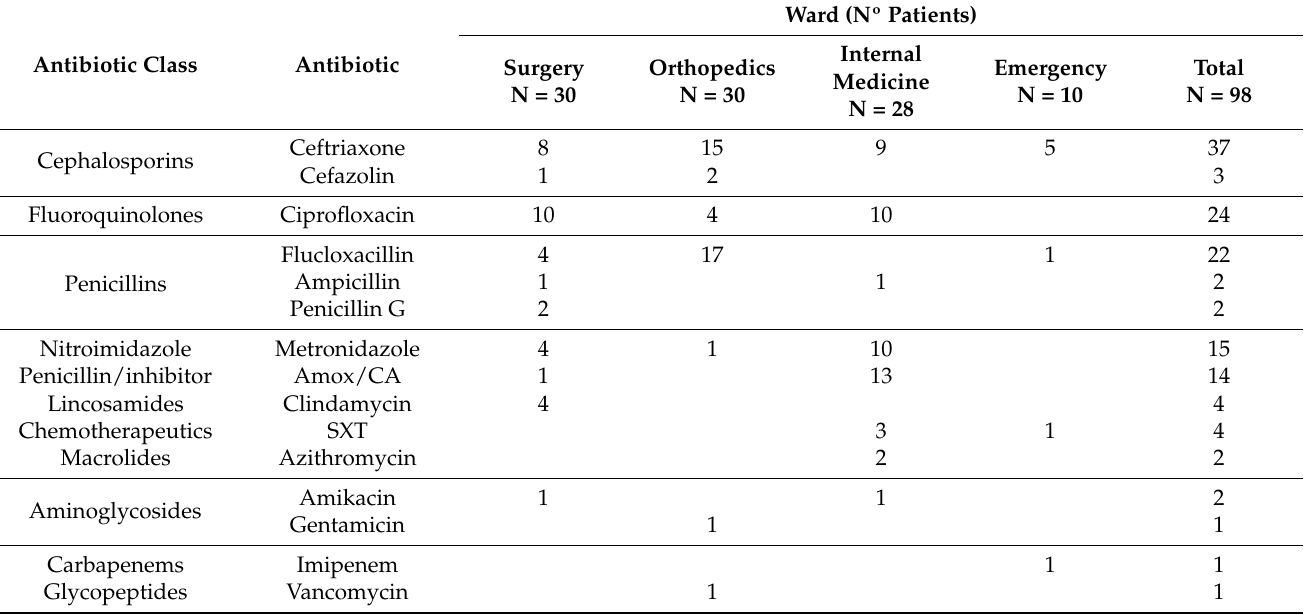
Table 1. Prescription of antibiotics among the 98 patients from the different